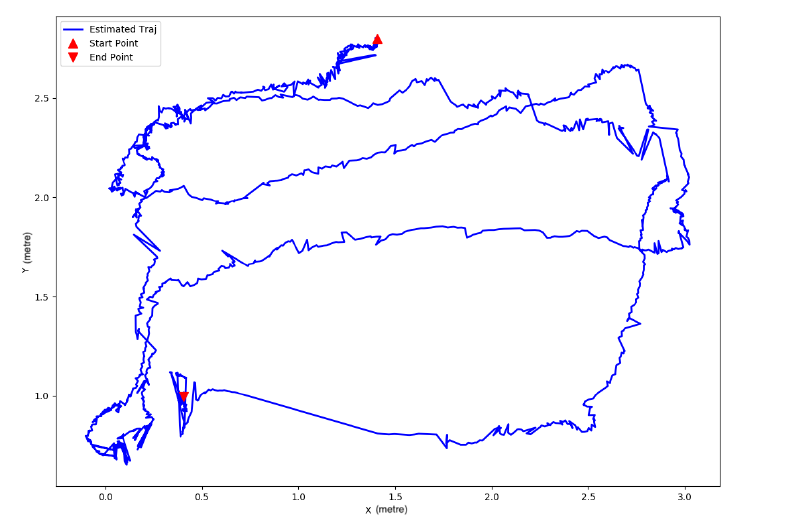
Figure 8. Lawnmower pattern—1st.